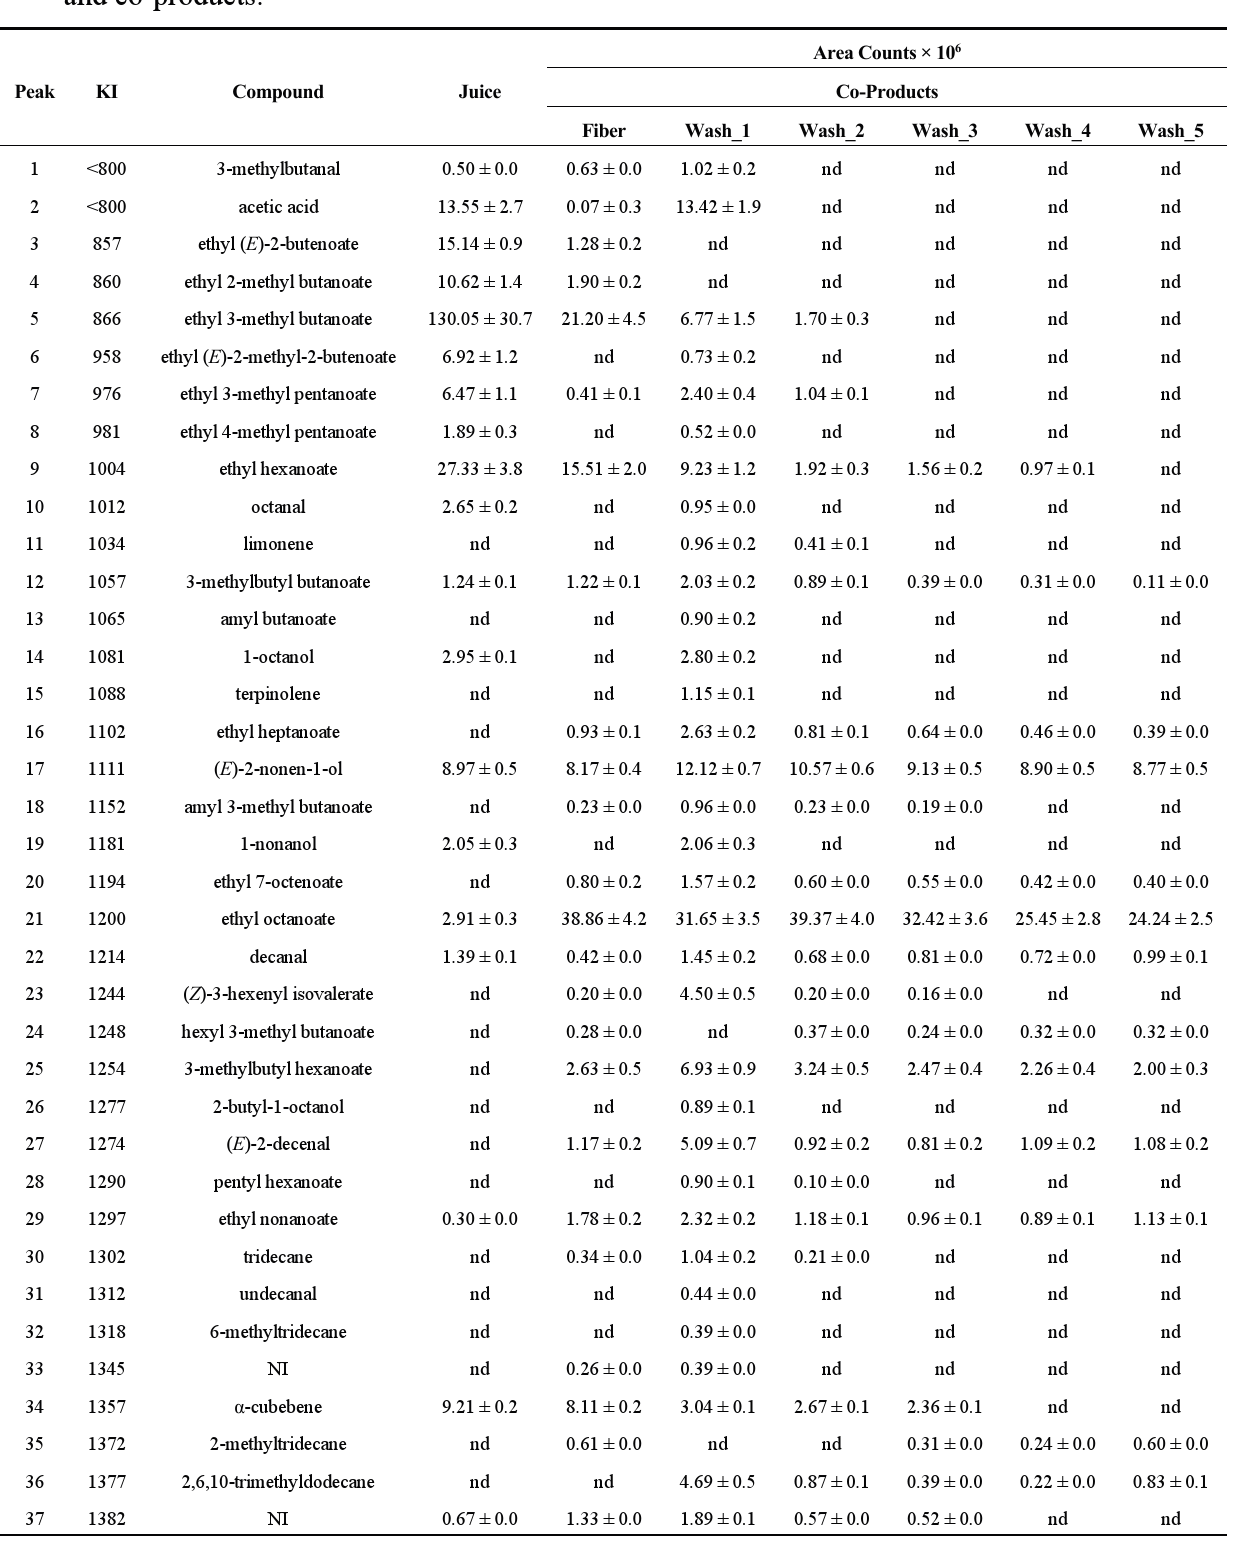
Table 1. Chromatogram area counts of headspace volatile compounds of cashew juice and